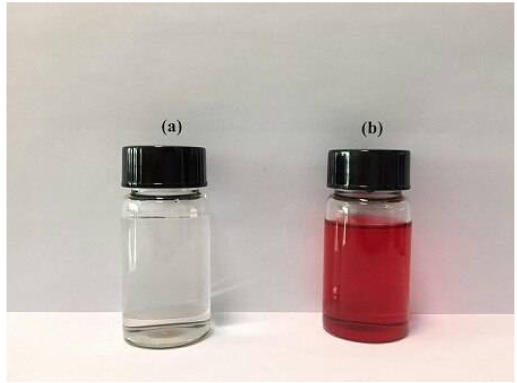
Figure 11. Ethylenediamine ( a ) before and ( b ) after extraction of CR from the CR-adsorbed